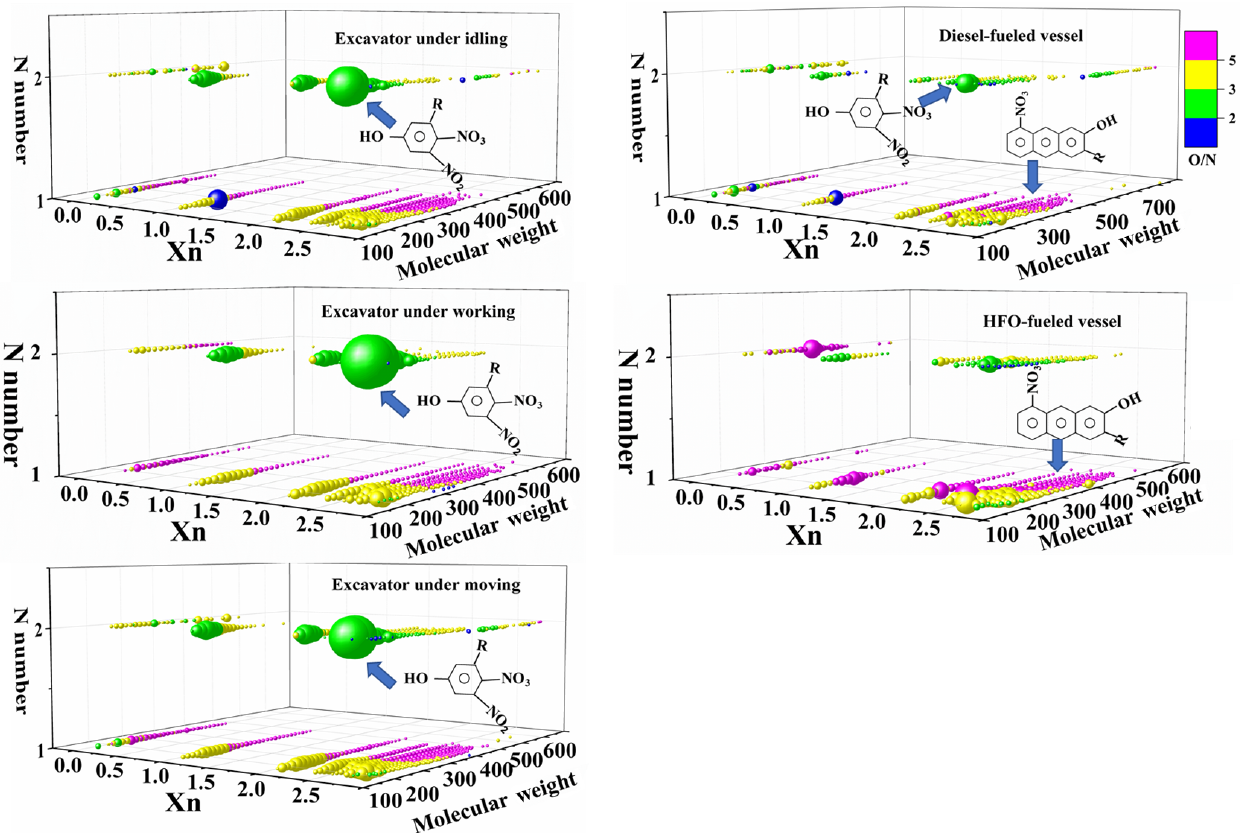
Figure 3. Molecular composition and possible structure of CHON for excavators in three modes and vessels using HFO and diesel.